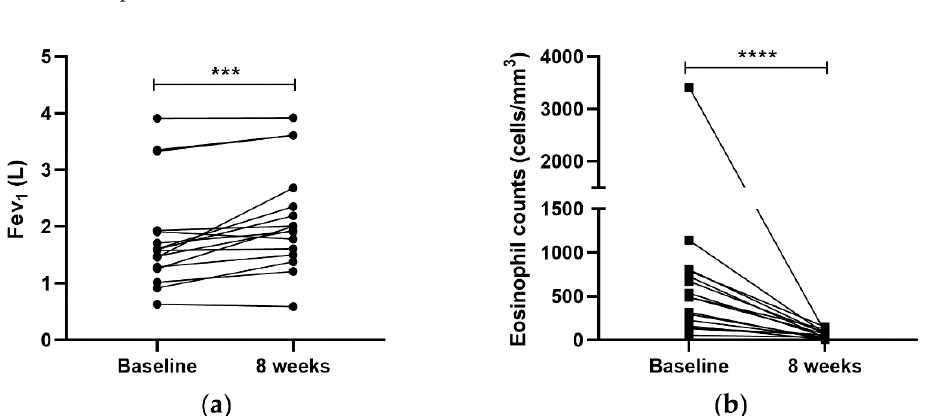
Figure 1. Anti-IL-5 biologics improved lung function and decreased peripheral eosinophils counts. Lung function ( a ) and peripheral eosinophil levels ( b ) were measured at baseline and an 8-week follow-up visit. After 8 weeks of mepolizumab or reslizumab drug administration, patients recovered their FEV 1 and lessened their peripheral eosinophils counts. *** p < 0.001, **** p < 0.0001.